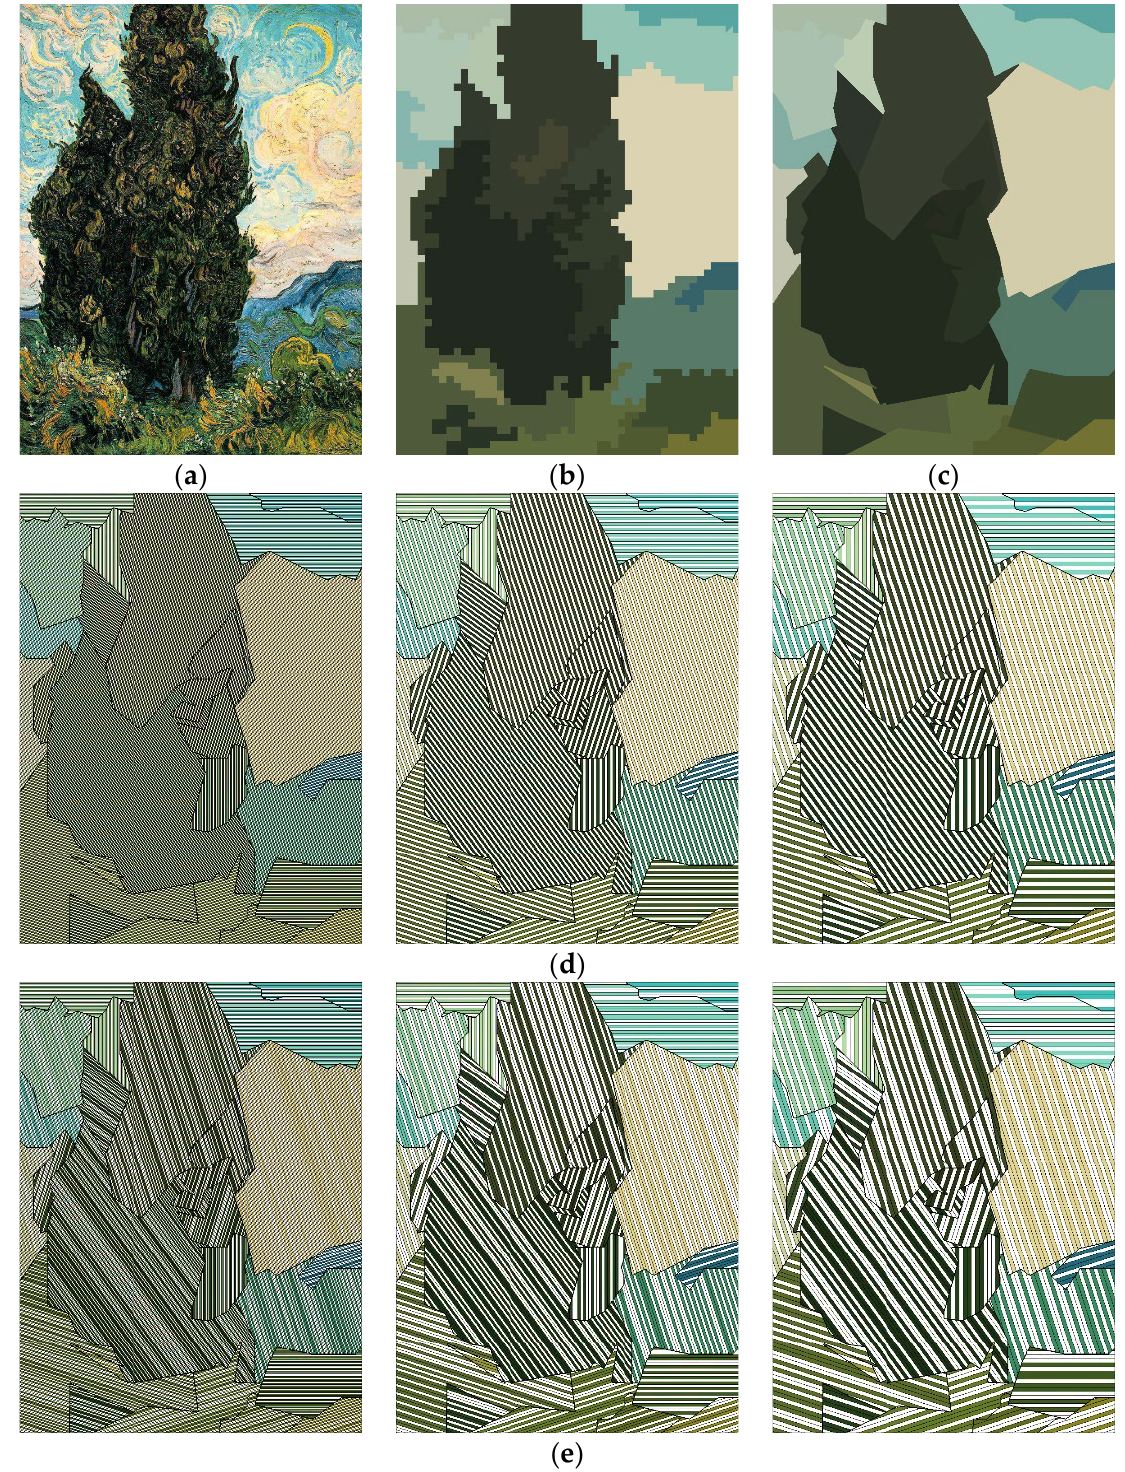
Figure 14. Experimental result 2. ( a ) An original image, “Cypresses,” by Vincent van Gogh, 1887. ( b ) The result of image segmentation of ( a ). ( c ) The result of polygon approximation of ( b ). ( d ) Three Futurism-like images created from ( a ) with the stripe widths of 3, 6, and 9 pixels, respectively. ( e ) Three stego-images created from ( a ) by embedding the message “Industry is the parent of success.” with the secret key “GOGH” and the stripe widths of 3, 6, and 9 pixels, respectively.